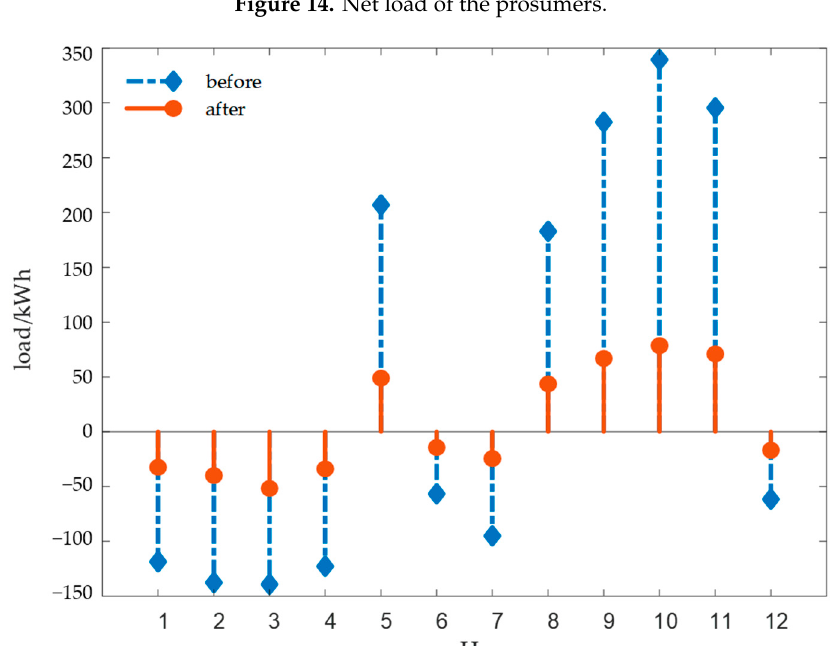
Figure 15. The comparison between supply and demand before and after participating in ESM.